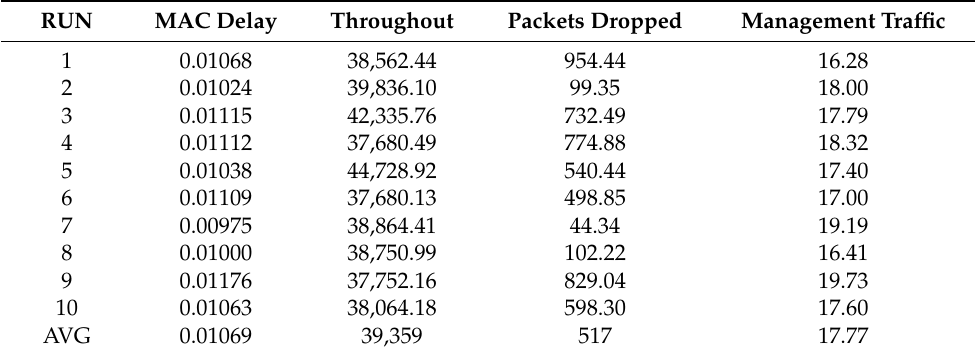
Table 11. Patient Bed Scenario ZigBee Standard.